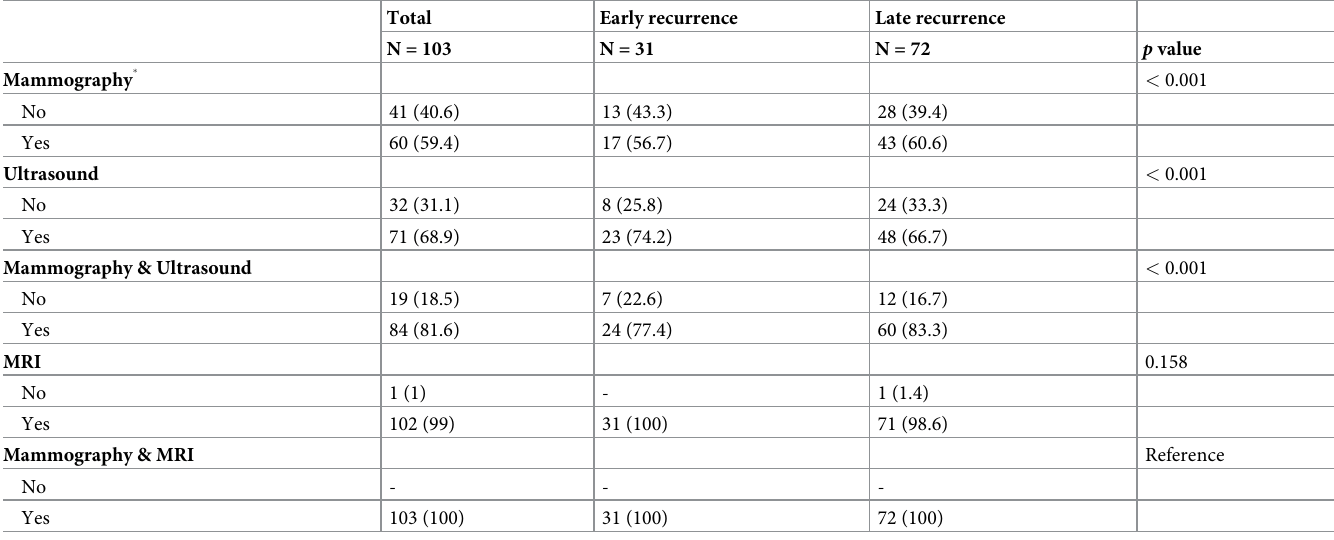
Table 3. Detectability of recurrent breast cancer by imaging